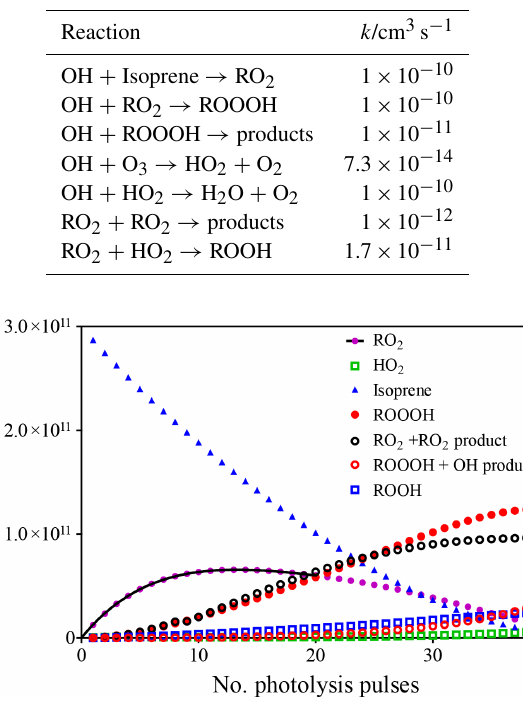
Table 1. Model used to estimate the accumulation of ROOOH in the photolysis cell before entering the FAGE cell; all rate constants have been taken from the most recent IUPAC evaluations (Atkinson et al., 2004, 2006).